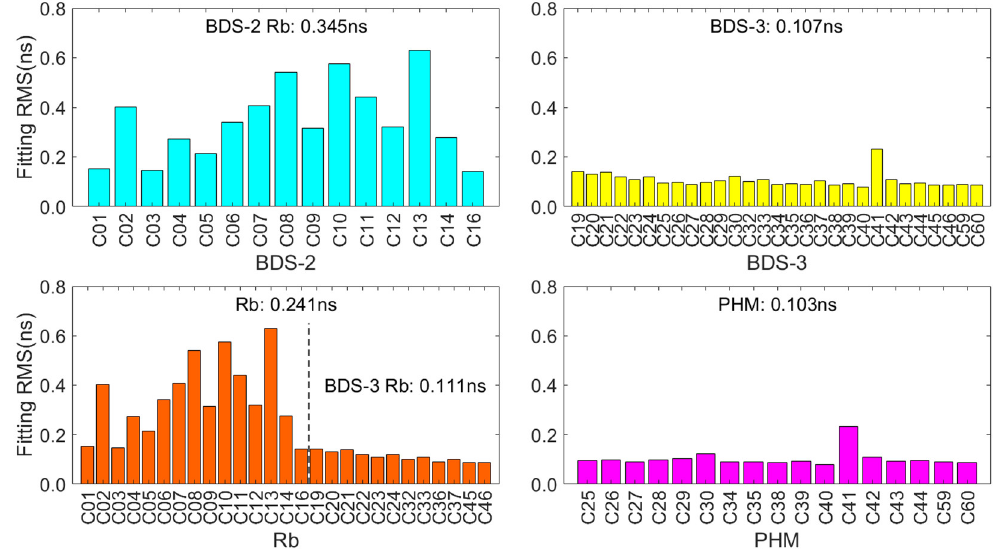
Figure 13. RMS of BDS clocks fitting residuals of different types.